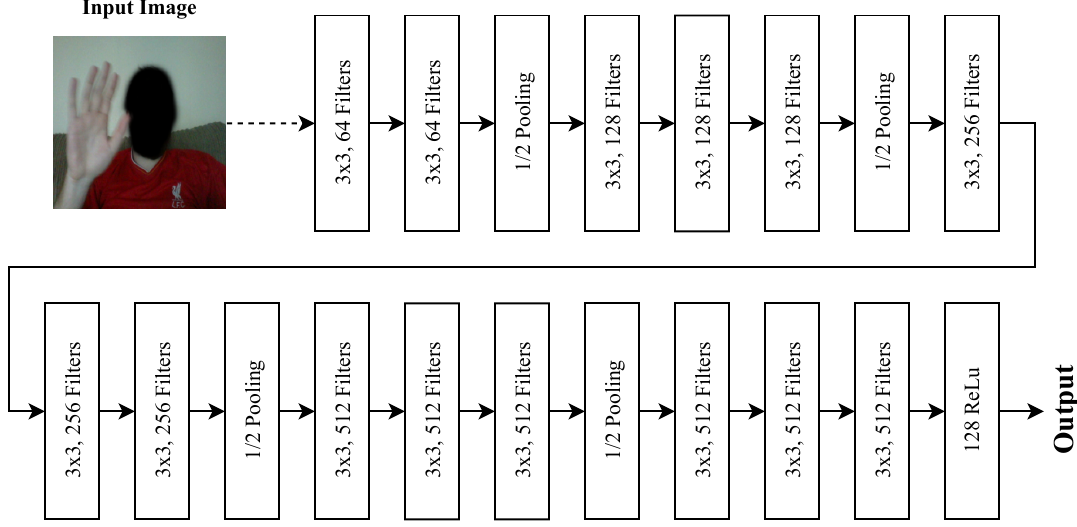
Figure 8. Feature extraction from the RGB branch of the network, the input image is passed through a fine-tuned VGG16 CNN [39] and then a layer of 128 ReLu neurons provide output. The network is trained via softmax output, but this softmax layer is later removed and the 128 outputs are used in late fusion with the Leap Motion network.